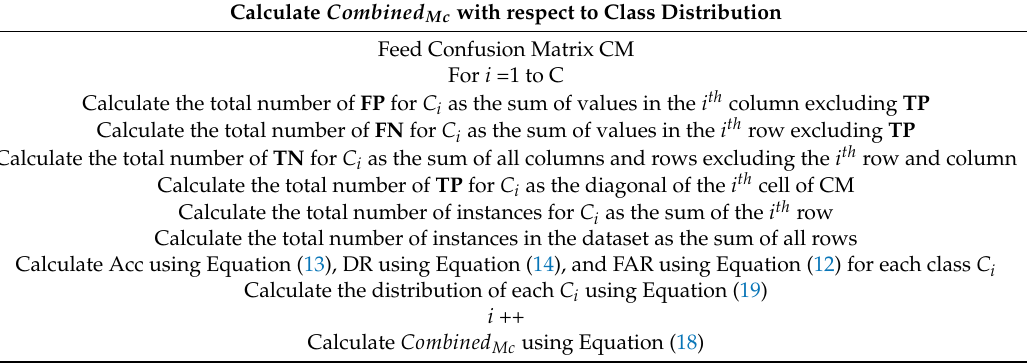
Table 6. Pseudo-code for the proposed Combined Mc metric